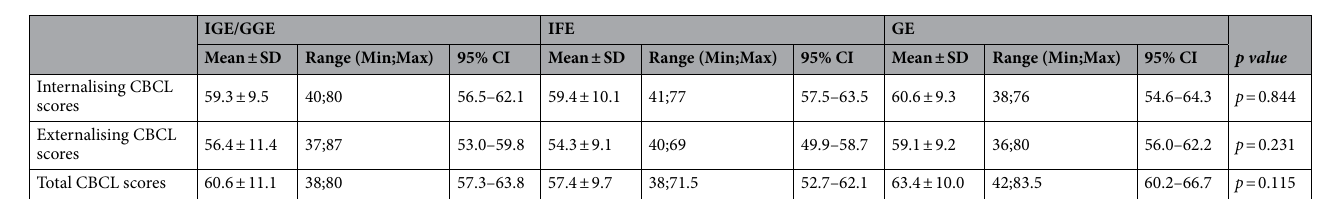
Table 4. Behavior across groups. Intergroup differences are considered significant at p ≤ 0.05. CBCL, Child Behavior Checklist; IGE/GGE, idiopathic/genetic generalized epilepsy; IFE, idiopathic focal epilepsy; GE, genetic epilepsy; CI, confidence interval; SD, standard deviation; Min, minimum; Max, maximum.